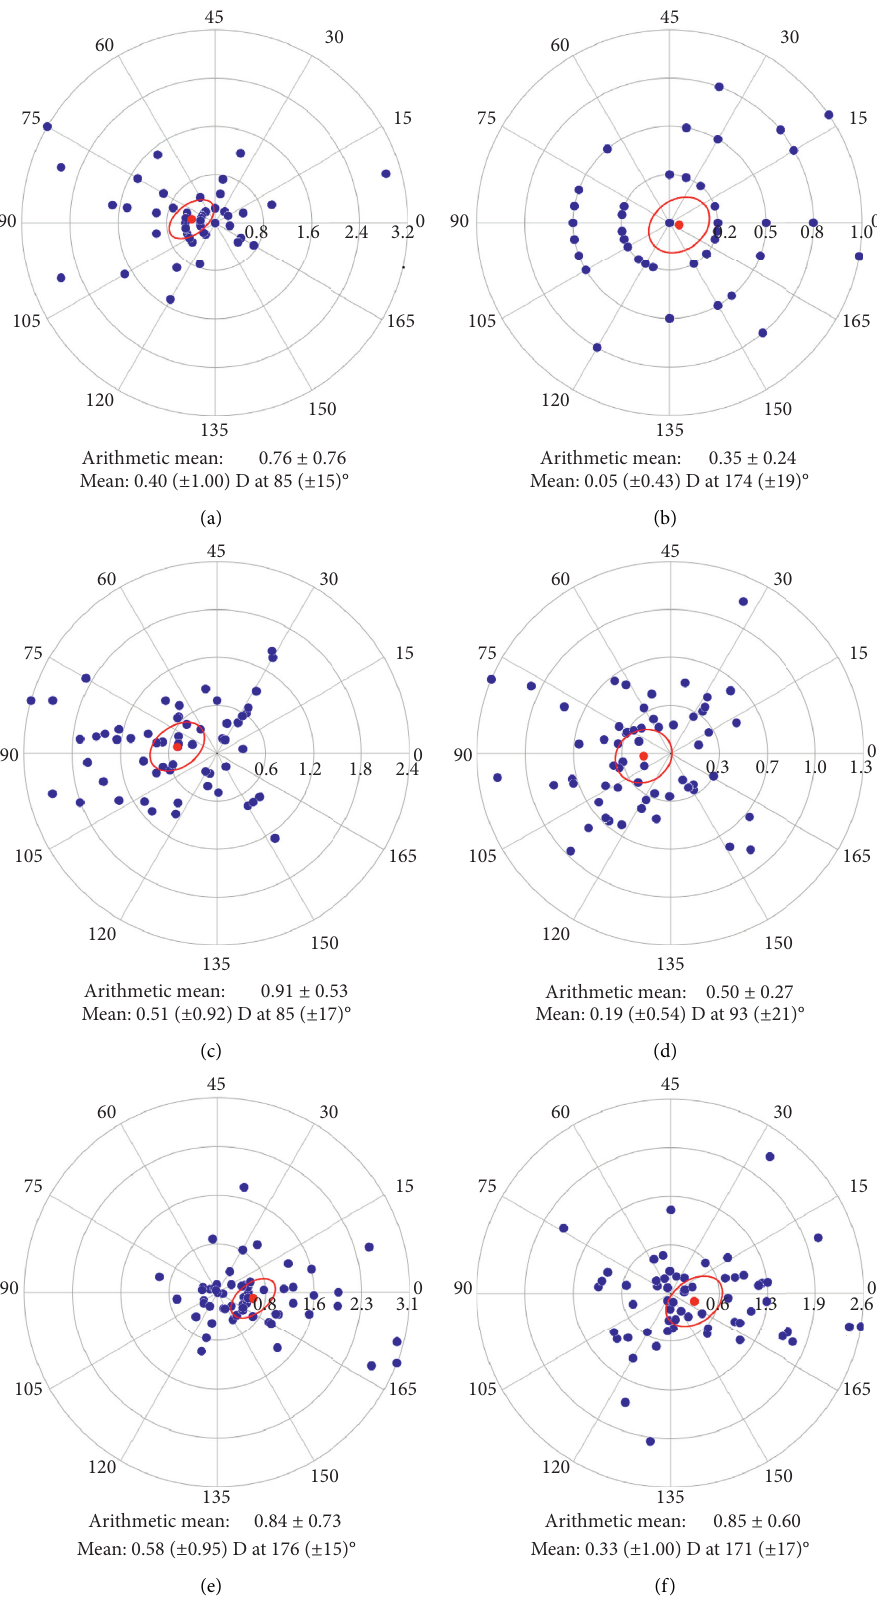
Figure 7: Preoperative refractive astigmatism (a), 6 months postoperative refractive astigmatism (b), preoperative corneal astigmatism (c), and 6 months postoperative corneal astigmatism (d). Difference between preoperative and 6 months postoperative refractive astigmatism (e) and corneal astigmatism